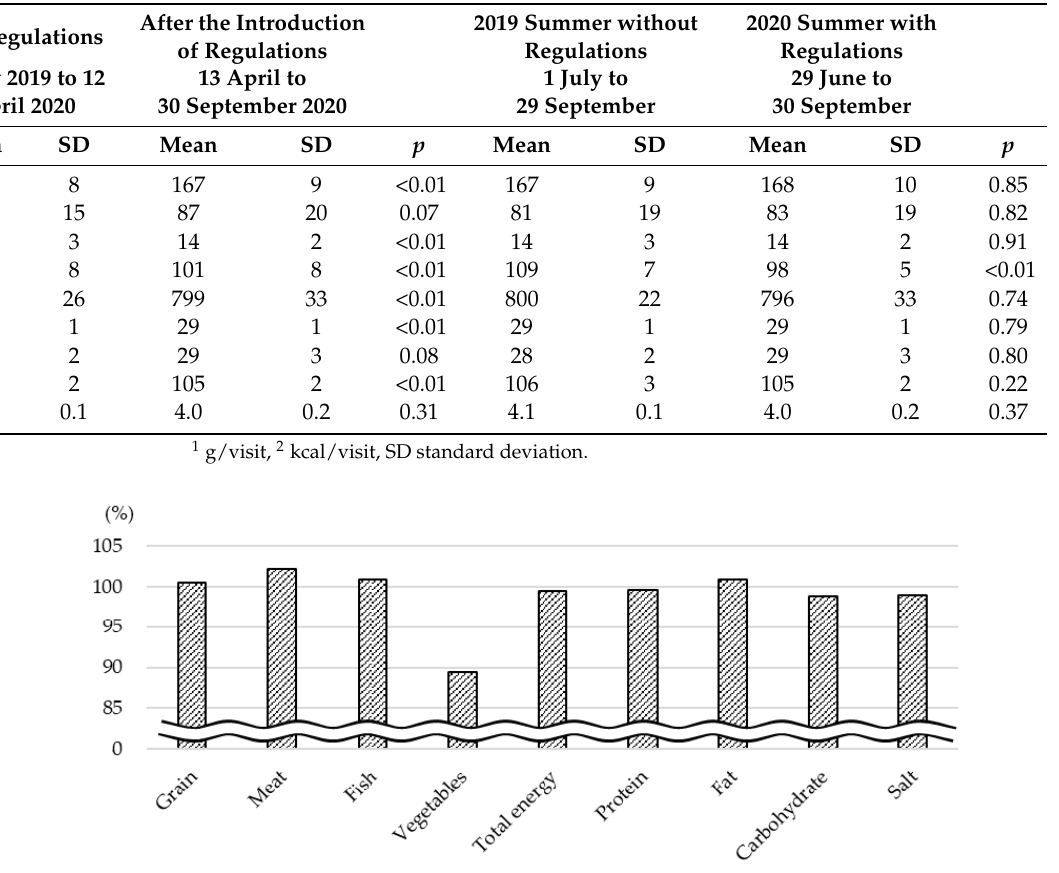
Figure 3. Proportion of the estimated mean food, total energy, and nutrient intake during summer 2020, when there were regulations, compared to summer 2019, when there were no regulations.